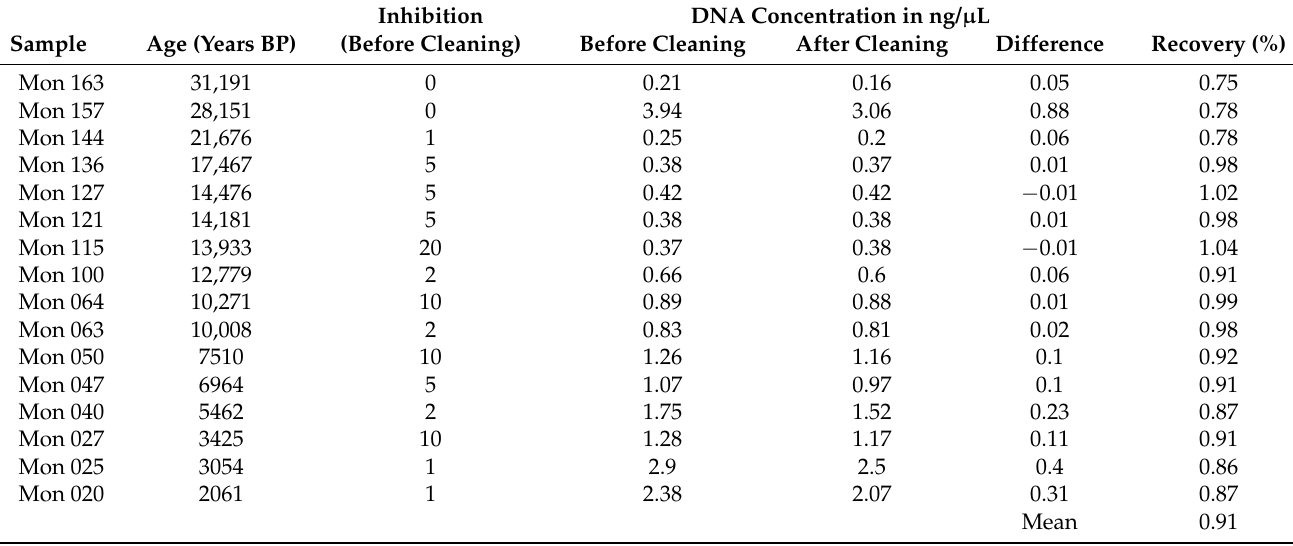
Figure A2. Comparison inhibition PowerSoil extracts with or without additional purification. The Zymo column was used once according to kit manual (green), inhibition after using two clean columns (light blue) and running the extract three times through the same Zymo column (pink). Table A1. DNA recovery after cleaning with the Zymo OneStep Inhibitor Removal Kit.